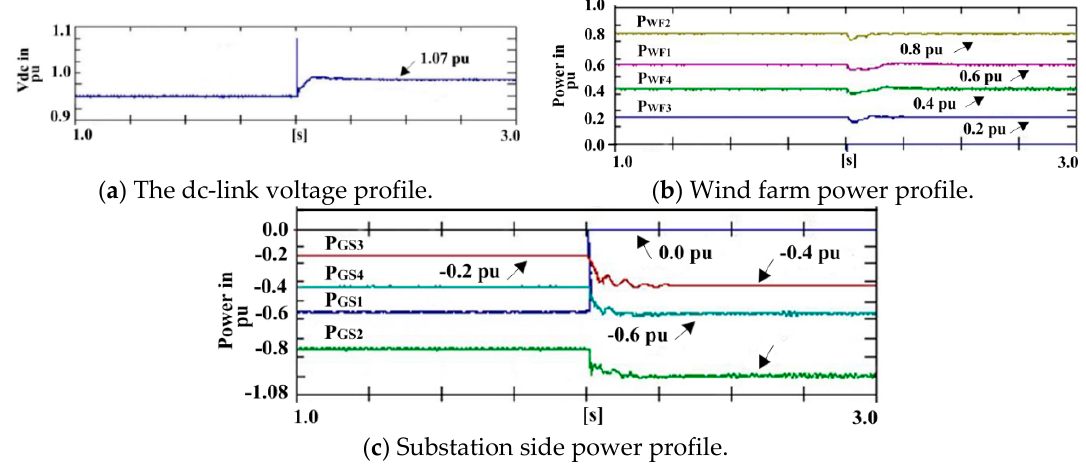
Figure 9. Disconnection of GS-VSC 1 from WFRT.